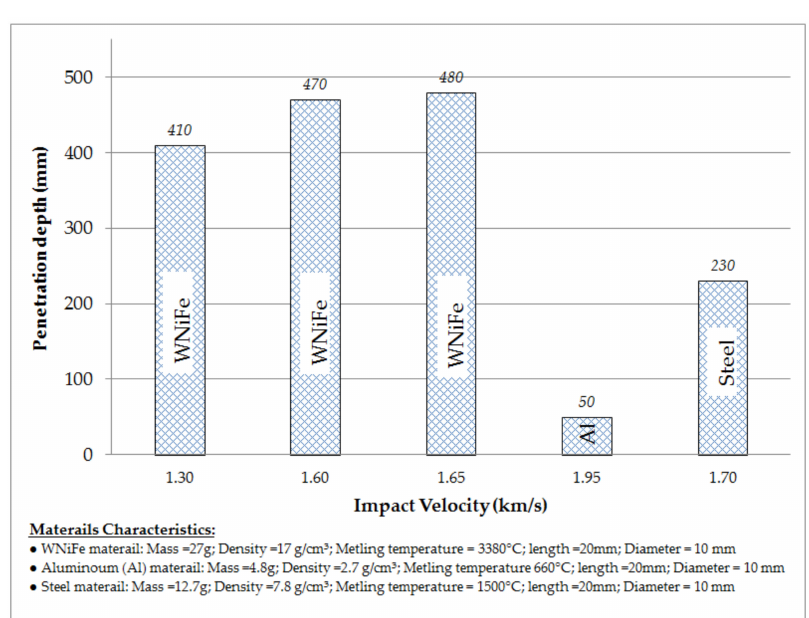
Figure 10. E ff ect of material properties of projectile on penetration